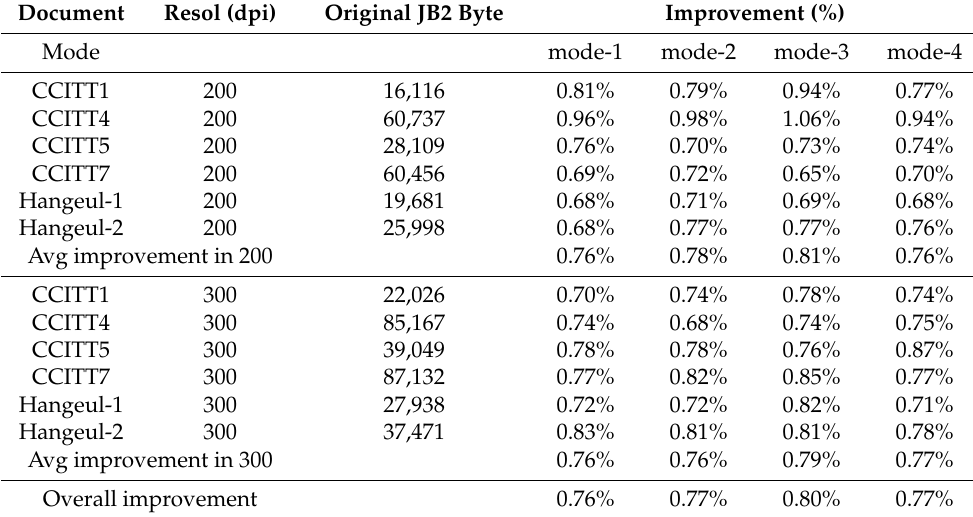
Table 15. 4-level LUT experimental results for JBIG2. ( α = β = 1.0).